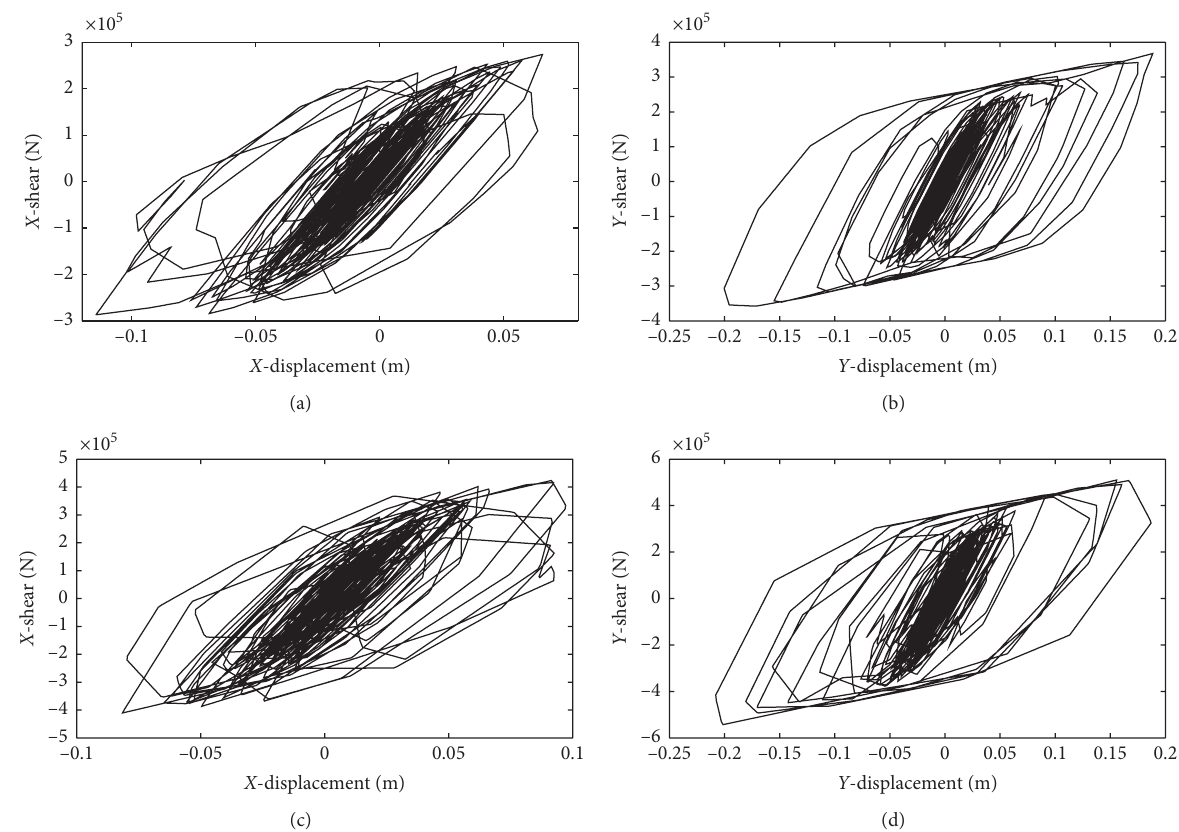
Figure 11: Comparison of the hysteresis loops of the central seismic isolator of SSIS-NC (a, b), CAMSBID-NC (c, d) structures under the effect of the 2011 Tohoku earthquake.